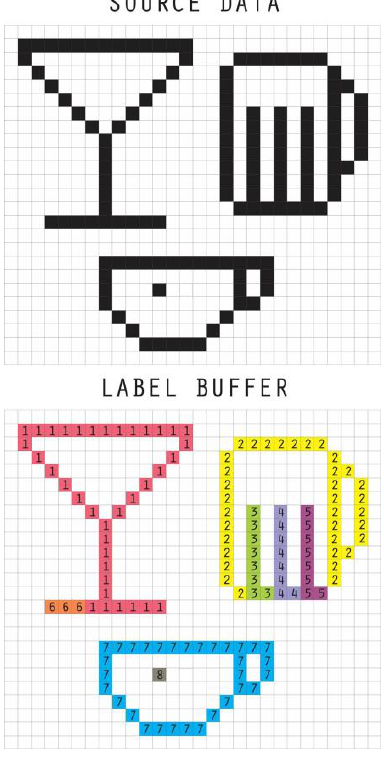
Fig. 10. Labeling example (with more than one label per